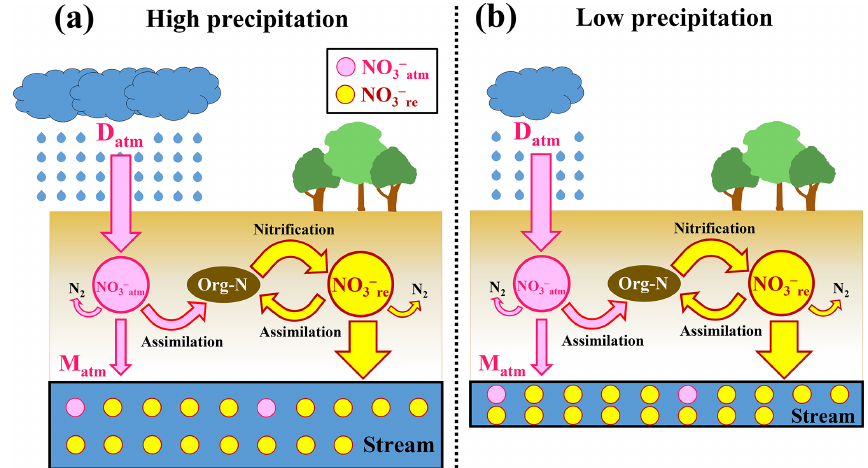
by yellow circles, the flows of 3 re ] 3